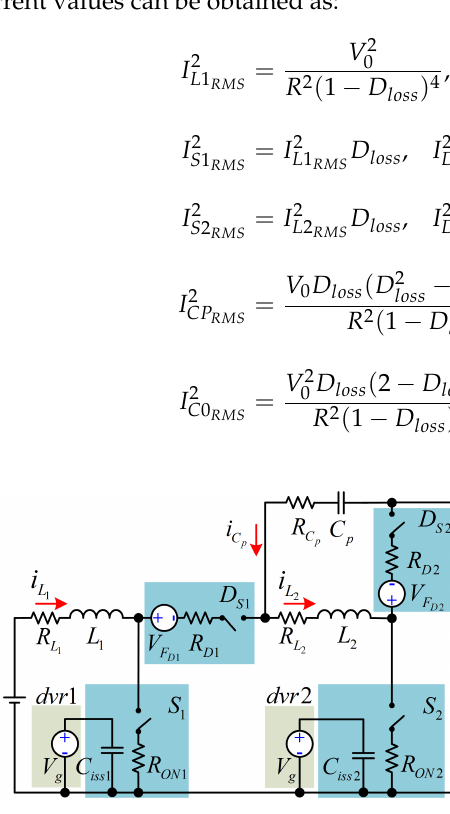
Figure 8. Equivalent circuit with the parasitics of elements.